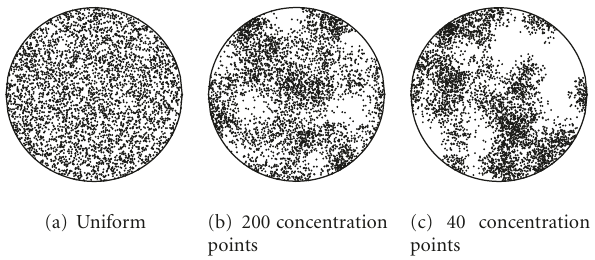
Figure 6: Representation of a 4.000 nodes topology with three di ff erent node distributions. Only the first one is